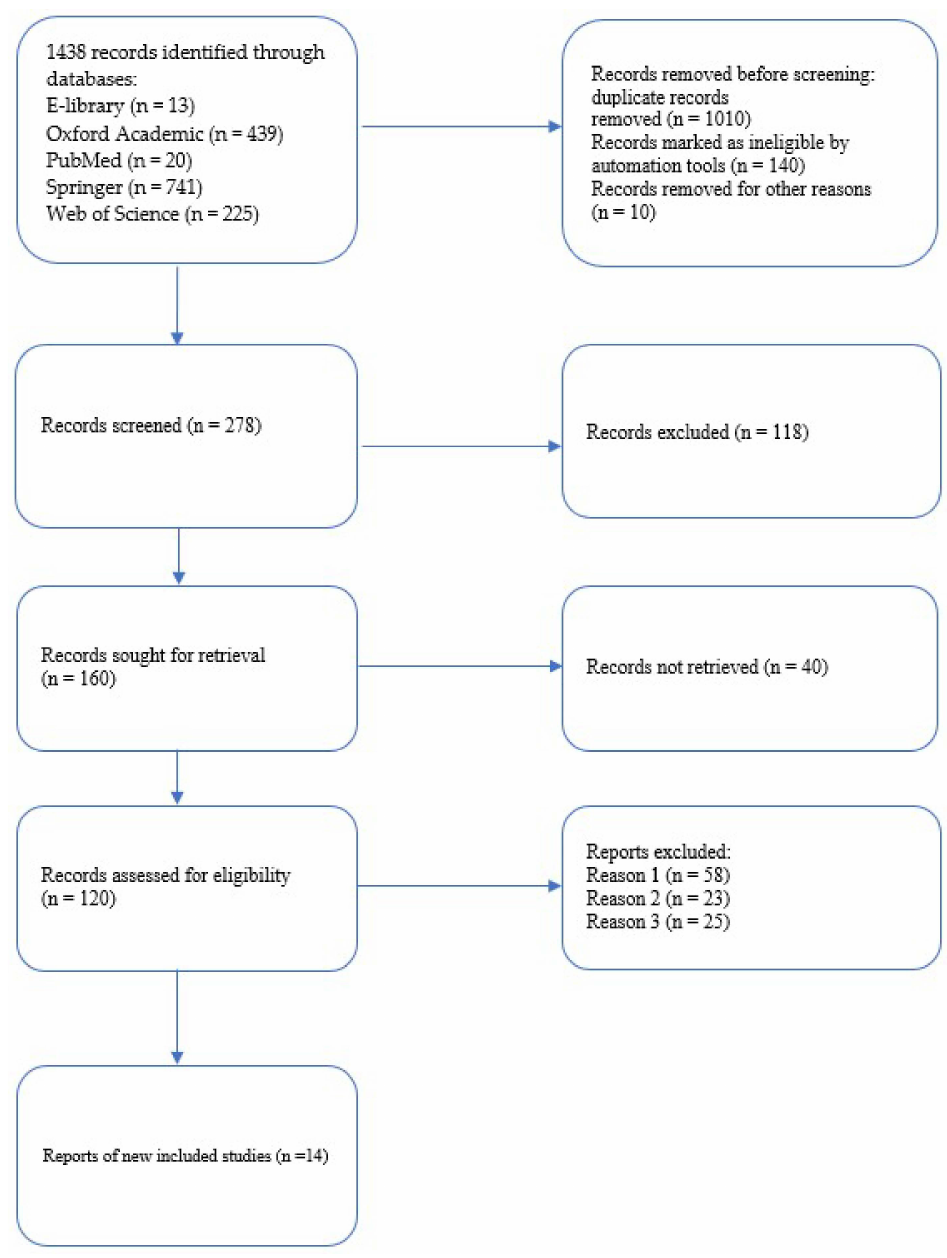
Figure 2. Flow chart diagram visualizing the database searches and the number of publications identified, screened, and the final full texts included in the present systematic review. Reason 1—there is no primary data on relative LTL in the article. Reason 2—the method of measuring relative LTL was carried out using an alternative method to the Ca. thon R. M. method. Reason 3—review